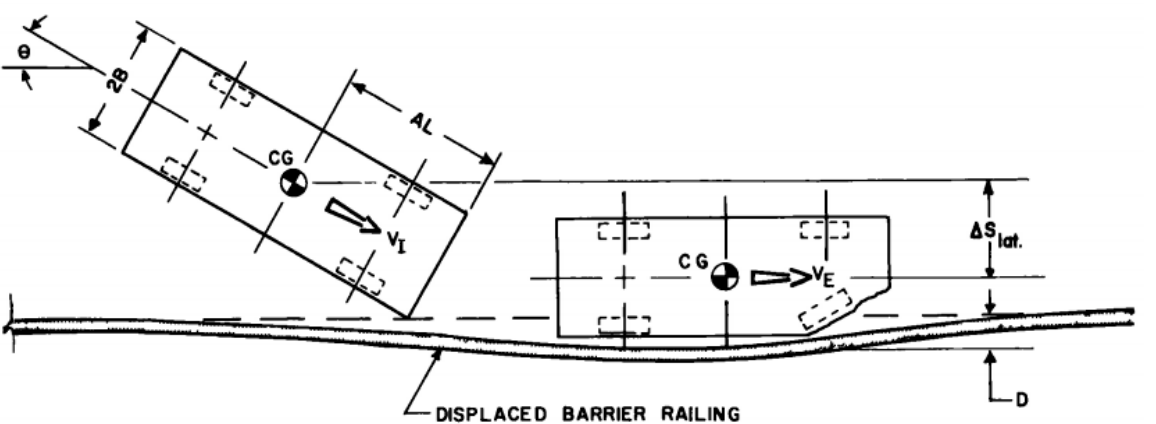
Figure 5. Collision in the Olson model.